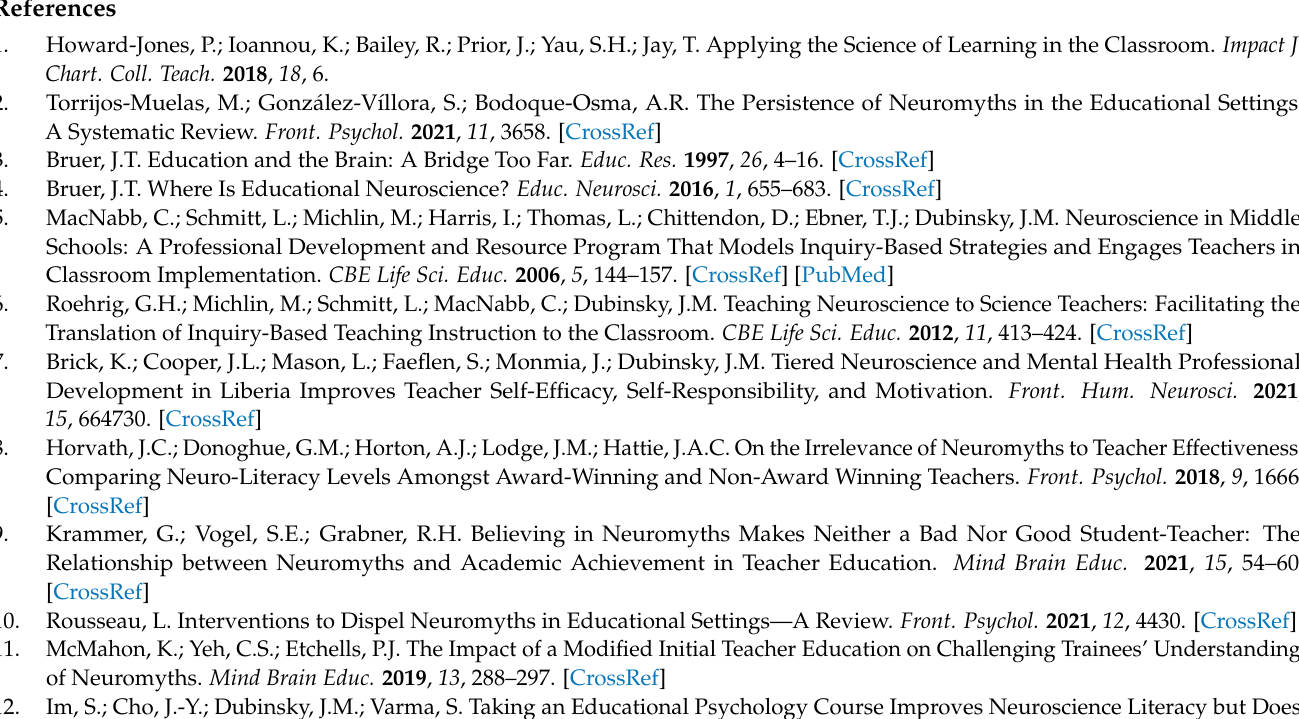
Table S1: Course content and survey statement alignment; Supplementary Table S2: Translation of Dekker et al.’ survey into